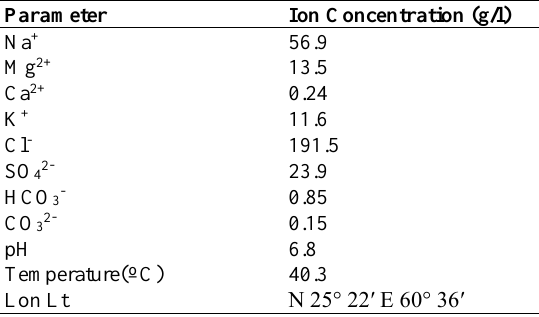
Table 1. Chemical characterization of Saltern